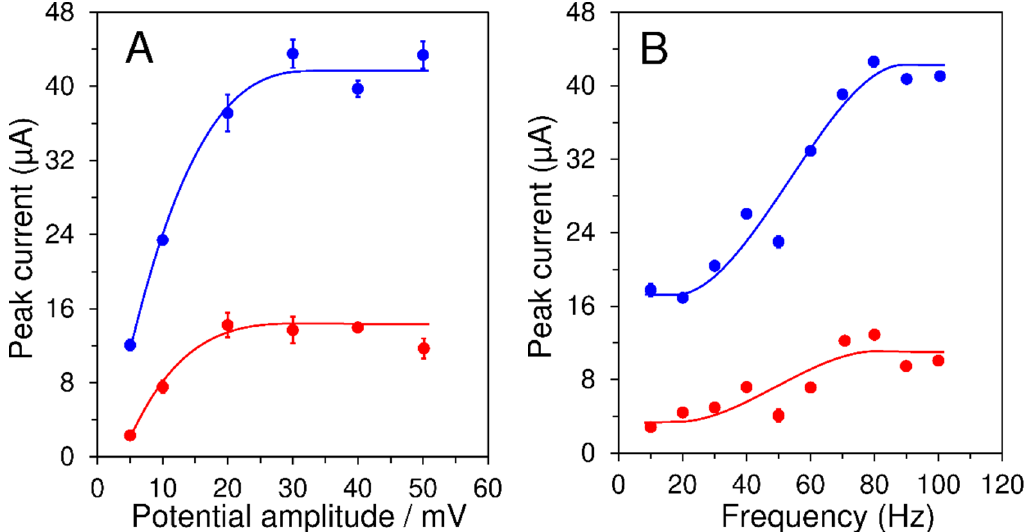
Figure 2. Dependence of anodic peak current VK1 (red) and α-TOH (blue line) on potential amplitude ( A ) and frequency ( B ). SWAdSV of 50-µmol L −1 α-TOH and 50-µmol L −1 VK1 adsorbed from its 50% aqueous–acetonitrile mixture onto GCE at stirring rate of 400 rpm for 5 min. Voltammetric detection was carried out in 0.01-mol L −1 HNO 3 containing 0.1-mol L −1 KCl (pH 2.08) at E dep = −0.1 V, t dep = 60 s,